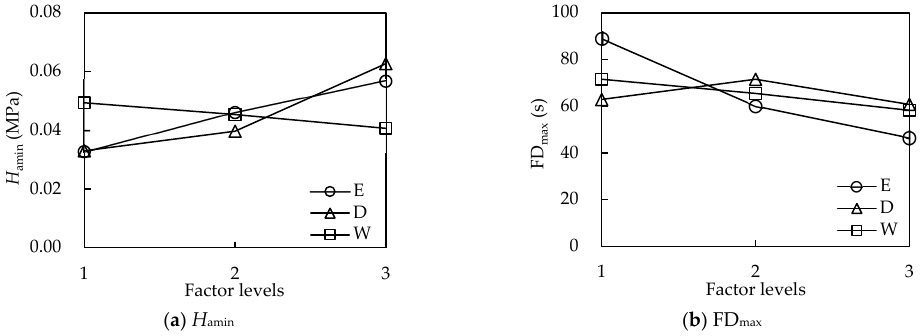
Figure 5. Effect of different factor levels on the minimum closing pressure ( H amin ) ( a ) and maximum flushing duration (FD max ) ( b ) of the automatic flushing valve (AFV).